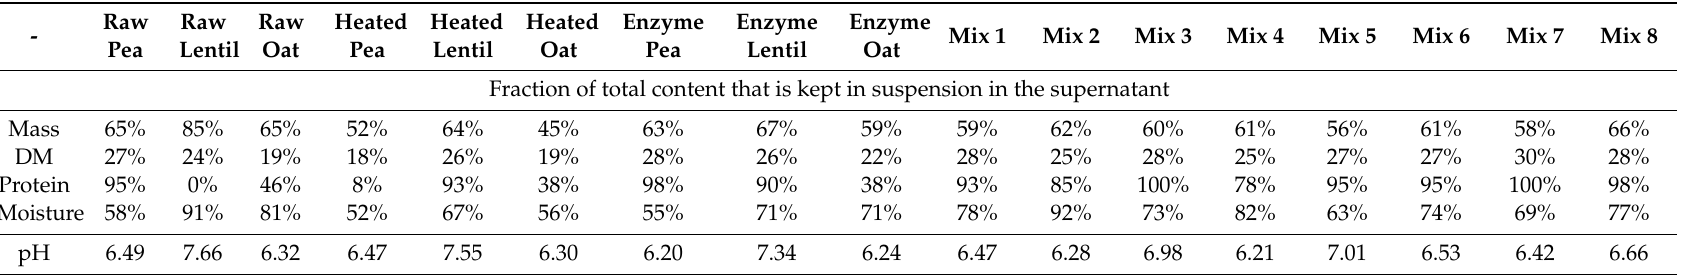
Table 5. Fraction of sample mass, fraction of dry matter (DM), fraction of protein and fraction of moisture kept in suspension. Additionally, the pH of each of the finished drinks / suspensions is